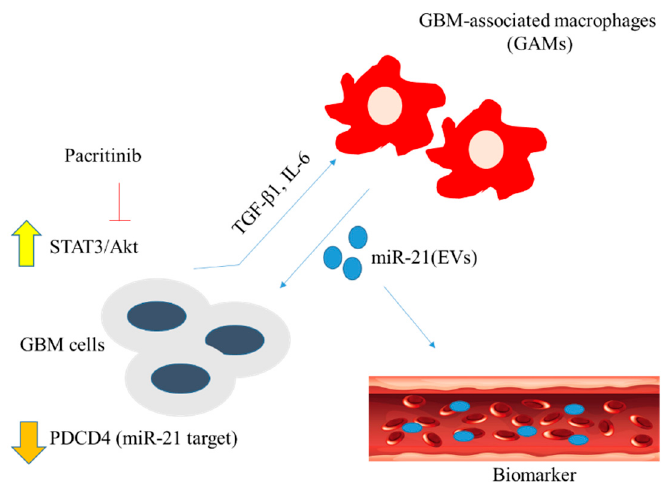
Figure 7. GAMs in the tumor microenvironment promote the survival of GBM cells via miR-21- enriched extracellular microvesicles (EVs). Mir-21 targets and suppresses the expression of tumor suppressor PDCD4 in GBM cells, leading to the elevated STAT3/Akt signaling. In turn, GBM cells secrete inflammatory cytokines TGF- β 1 and IL-6 and promote M2 polarization. Pacritinib (STAT3